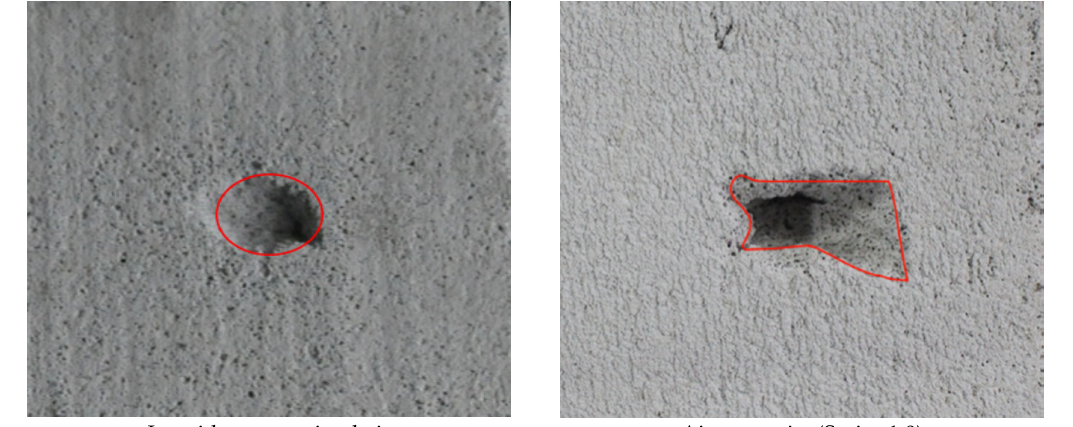
Figure 18. The erosion pattern of specimens.